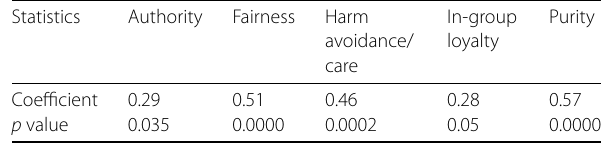
Table 4 Correlation statistics between MFD-generated and hand-coded moral scores for 100 political extremist-written tweets